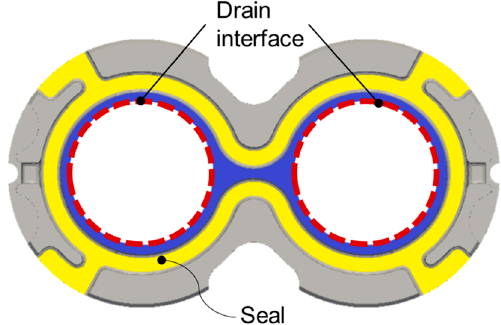
Figure 10. Configuration of the balance side of the lateral bushing in the prototype EGM used in the measurements, with the drain interface marked in red (Dhar and Vacca [8]).